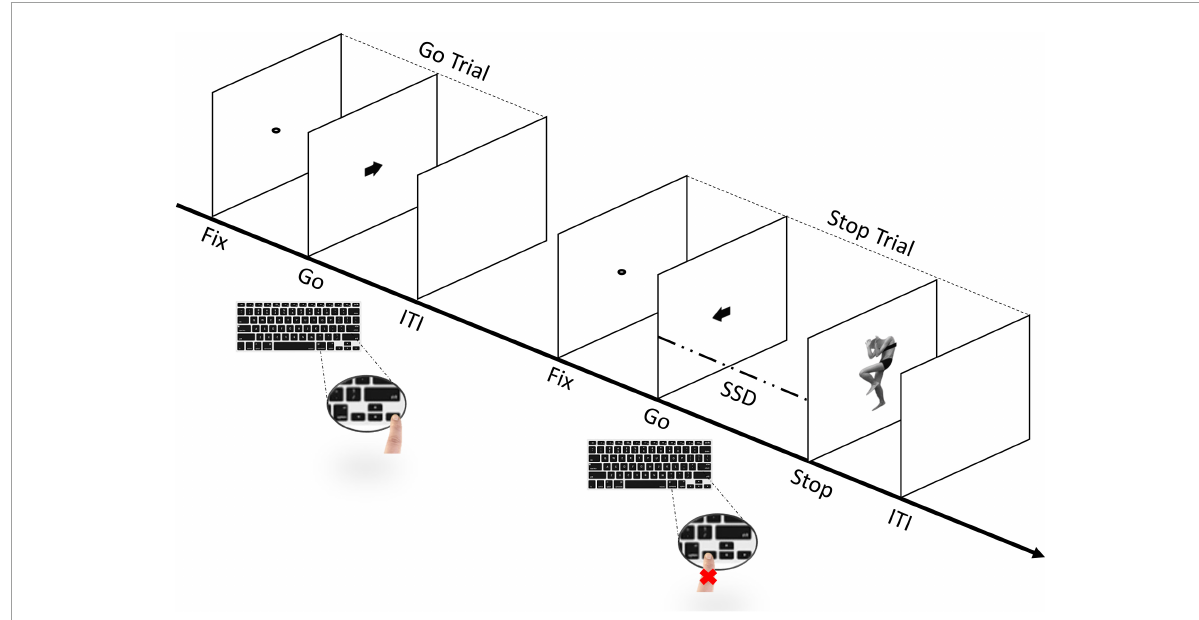
FIGURE2 Sequence of trials in the stop-signal task (SST). The experimental task includes both go- and stop-trials (Lappin and Eriksen, 1966; Logan and Cowan, 1984b; Logan et al., 2014; Verbruggen et al., 2019). Participants perform a short practice block and, immediately afterward, four experimental blocks. Each block includes a total of 128 trials, of which 96 are go-trials (75%) and 32 are stop-trials (25%). In go-trials, participants respond to the go-task (i.e., the direction of the arrow that appears on the screen) by pressing the corresponding arrow key on the keyboard. In stop-trials, the arrow is followed by a “Stop” signal after a variable stop-signal delay (FIX, fixation duration; SSD, stop signal delay; ITI, intertrial interval), instructing participants to suppress the imminent go response. The initial value of the SSD was set to 150 ms and adjusted individually and dynamically throughout the experiment (i.e., staircase procedure).